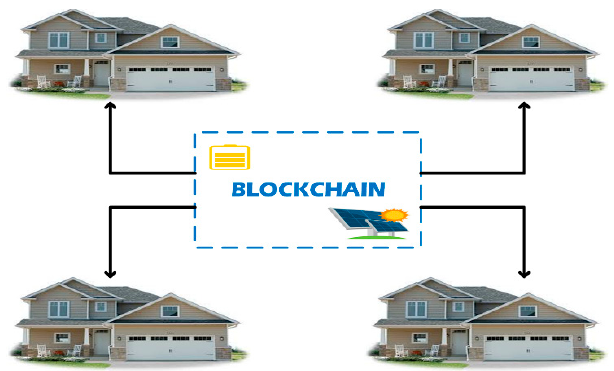
Figure 1. Illustration of Centralized Energy Sharing (CES) operating strategy.